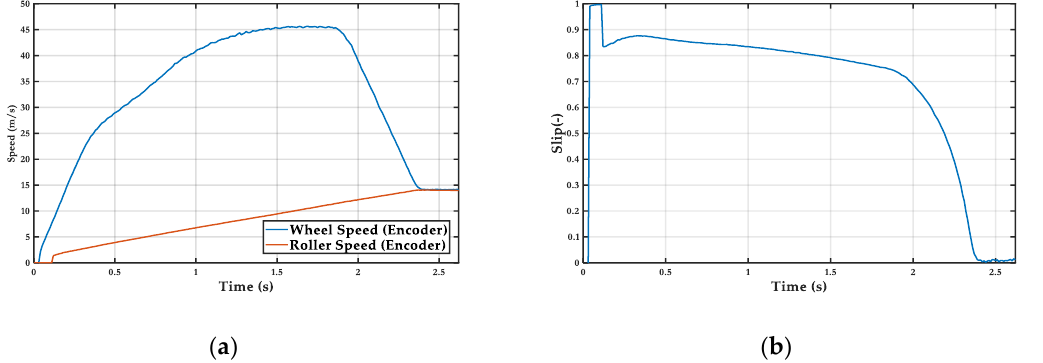
Figure 8. Controller off test: ( a ) wheel and roller speed, ( b ) wheel slip.